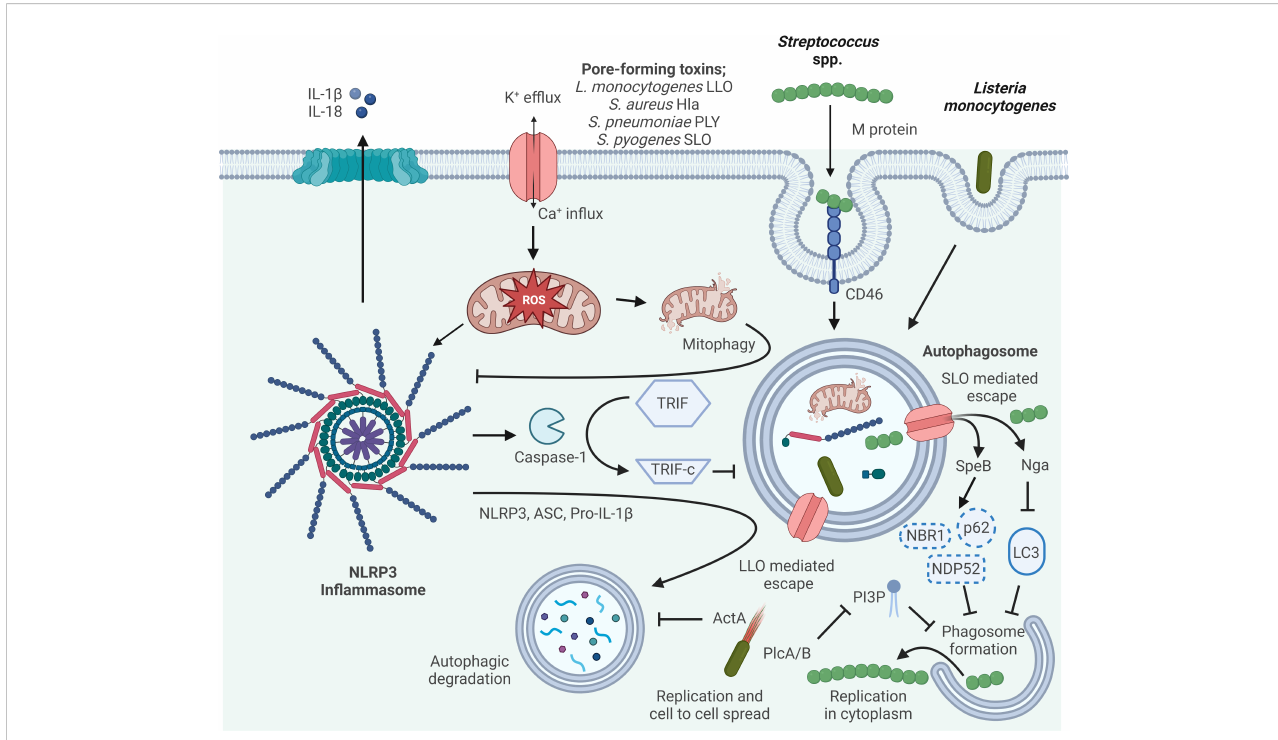
FIGURE 2 Mechanisms of autophagy/NLRP3 in fl ammasome by Gram-positive bacteria interaction. Autophagy can inhibit NLRP3 in fl ammasome activation by reducing ASC, increasing NLRP3 phosphorylation, and eliminating ROS. Activated Caspase-1 directly cleaves TRIF, thereby diminishing TRIF-mediated autophagy. The M protein of S. pyogenes binds the CD46 receptor to facilitate internalization, and subsequently S. pyogenes escapes from the phagosome via streptolysin O (SLO)-dependent pore formation. In the host cytosol, streptococcal pyrogenic exotoxin B (SpeB) degrades the autophagy adapter proteins p62, NDP52 and NBR1, and NAD-glycohydrolase (Nga) disrupts LC3 formation thereby inhibiting phagosome formation and escape from autophagy allowing for S. pyogenes cytosolic replication. LLO, listeriolysin O, pore-forming acts to damage and disrupt the vacuole membrane. Surface protein A (ActA) recruits the host Arp2/3 complex and Ena/VASP to the bacterial surface, which disguises the bacteria from autophagic recognition. Phosphatidylinositol-speci fi c phospholipase C (Plc) A and B expressed by L. monocytogenes interfere with the production of phosphatidylinositol 3-phosphate (PI3P), a phospholipid required for phagosome formation. Escape from autophagy allows for L. monocytogenes replicating within the host cytosol and cell-to-cell